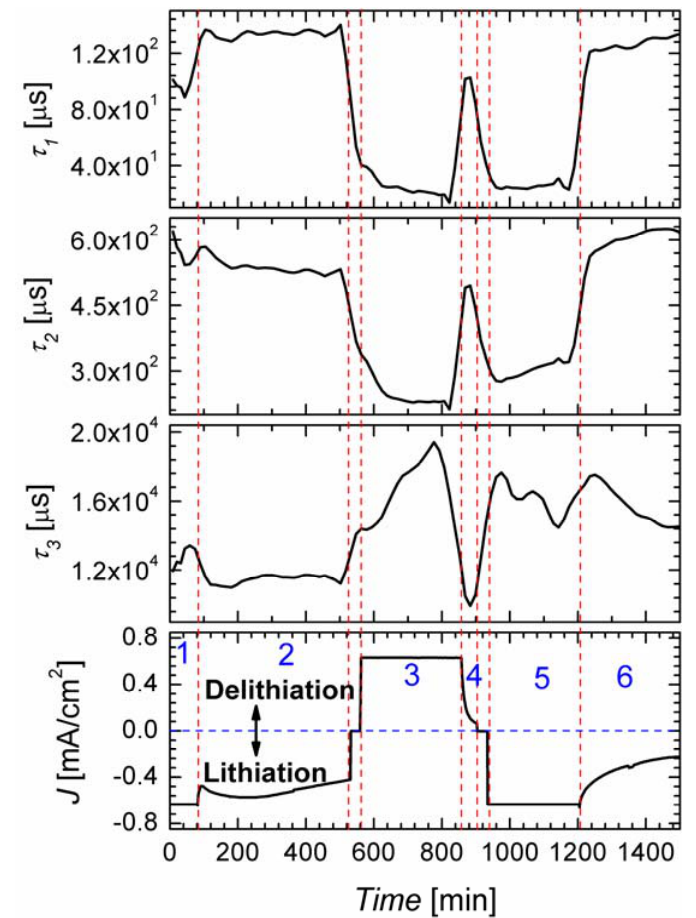
Figure 6. Plots of the different time constants obtained by fast Fourier transformation impedance spectroscopy (FFT-IS) during the lithiation/delithiation process of the wires. The current density J during cycling is shown as reference. The plots are divided into six sections. Sections 1, 3 and 5 are obtained under constant current, and Sections 2, 4 and 6 under constant